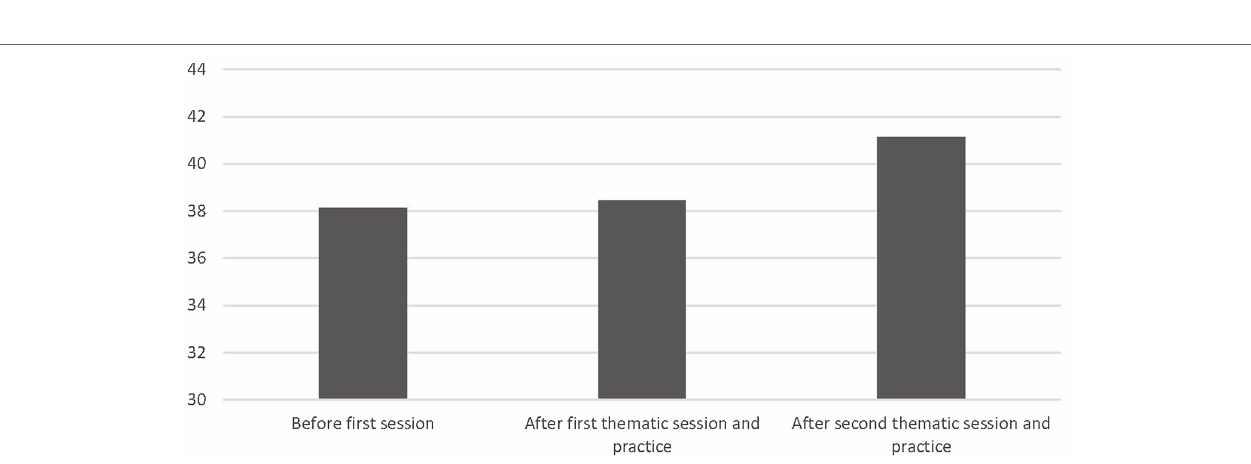
FIGURE 5 | Mean emotional wellbeing scores in Study 1 as a function of repeated attendance of a thematic session and practice afterward. Higher cores indicate greater emotional wellbeing. Scores could be from 8 (lowest) to 56